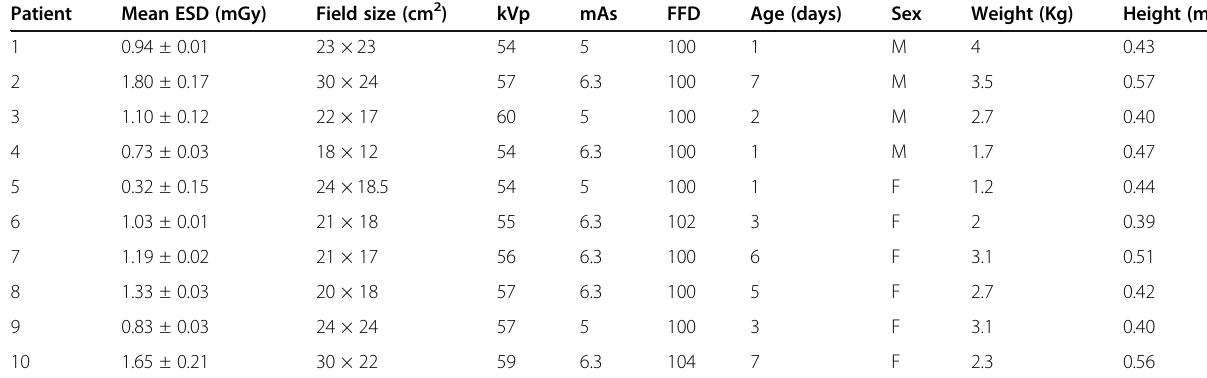
Table 2 Entrance surface dose (ESD) and other parameters for newborn between 1 and 7 days Patient